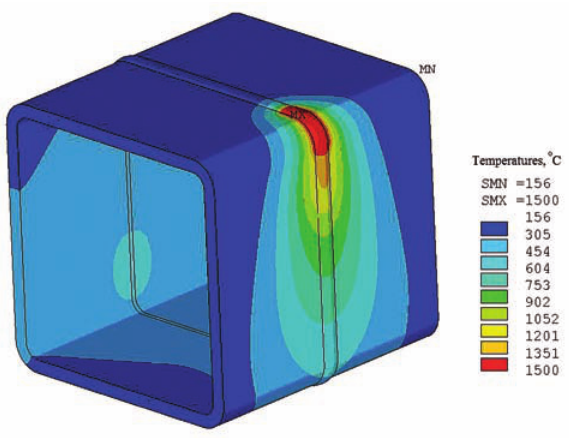
Fig. 14. Positions of coordinate axes regarding to welded joint